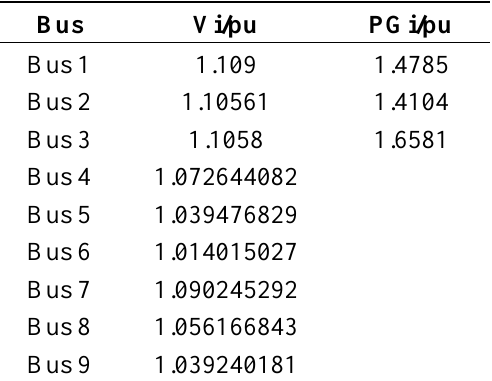
Table 11. OOP given by proposed method.